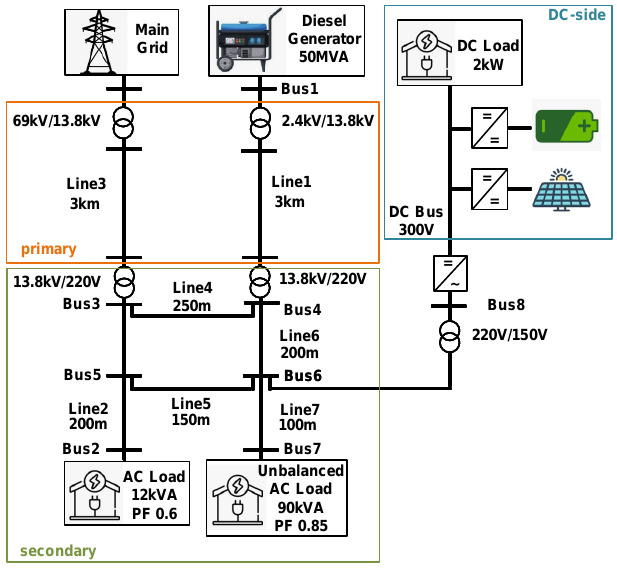
Figure 2. The structure of a typical hybrid microgrid.